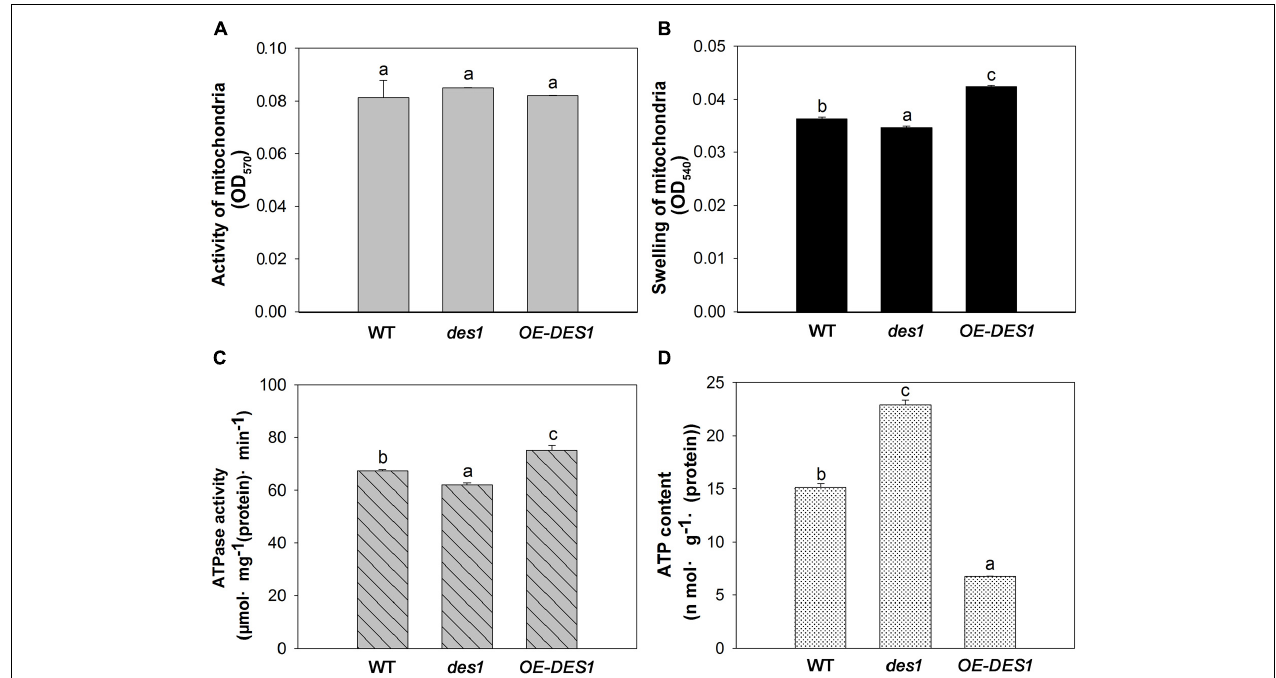
FIGURE 4 | Effects of H 2 S on mitochondrial functions in WT, des1 and OE-DES1 under drought-stress conditions. Leaves of 4-week-old after withholding water for 1 week were collected and the mitochondria were isolated and purified. (A) Activity levels of mitochondria and (B) swelling of mitochondria according to the method previously described (Du et al., 2014). (C) ATPase activity levels of mitochondria according to the method previously described (Toribarn et al., 1966). (D) ATP contents of mitochondria in WT, des1 and OE-DES1 were measured by the luciferin-luciferase (Promega, Madison, WI, United States). Data are means ± SEs of three independent experiments; bars marked with the same letter did not differ significantly at p <